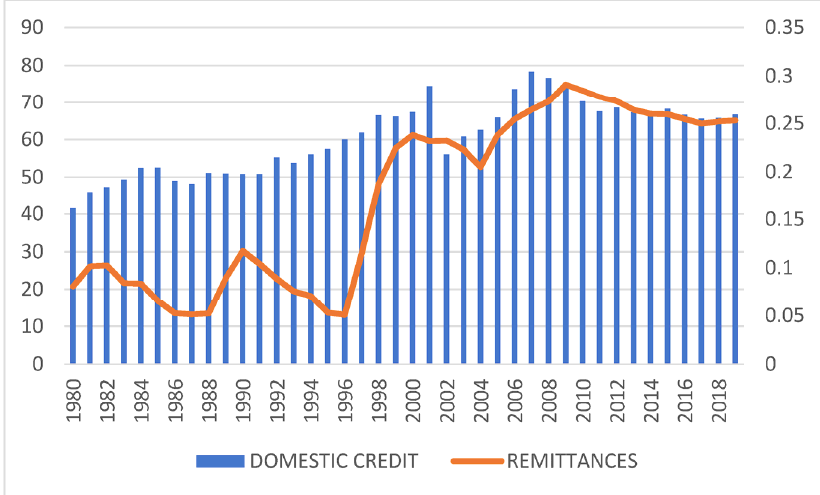
Figure 1. Trends in remittances and financial development in South Africa. Source: World Bank, 2019.